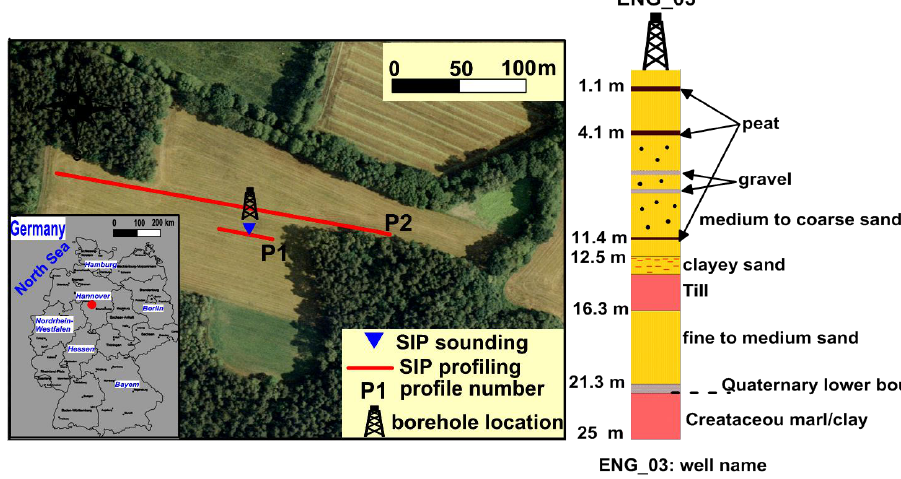
Fig. 1. (left) Location map of Schillerslage test site (Germany), available borehole, SIP field 8 Fig. 1. (Left) Location map of the Schillerslage test site (Germany), available borehole, SIP field measurements and SIP profile numbers measurements and SIP profile numbers (inset map, © Google Earth map). (Right) Lithology of 9 (inset map, © Google Earth map). (Right) Lithology of the Schillerslage test the Schillerslage test site. 10